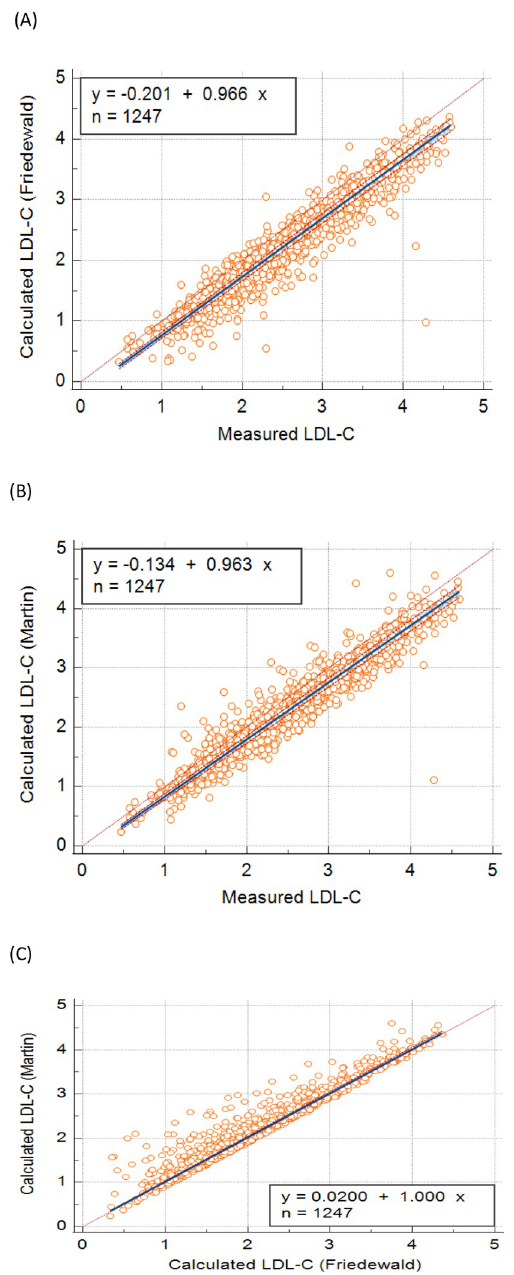
Fig 1. The comparison of calculated to measured low-density lipoprotein (LDL-C) using Passing- Bablok regression analysis. (A) Friedewald formula and measured LDL-C. (B) Martin Hopkins formula and measured LDL-C. (C) Friedewald formula and Martin Hopkins